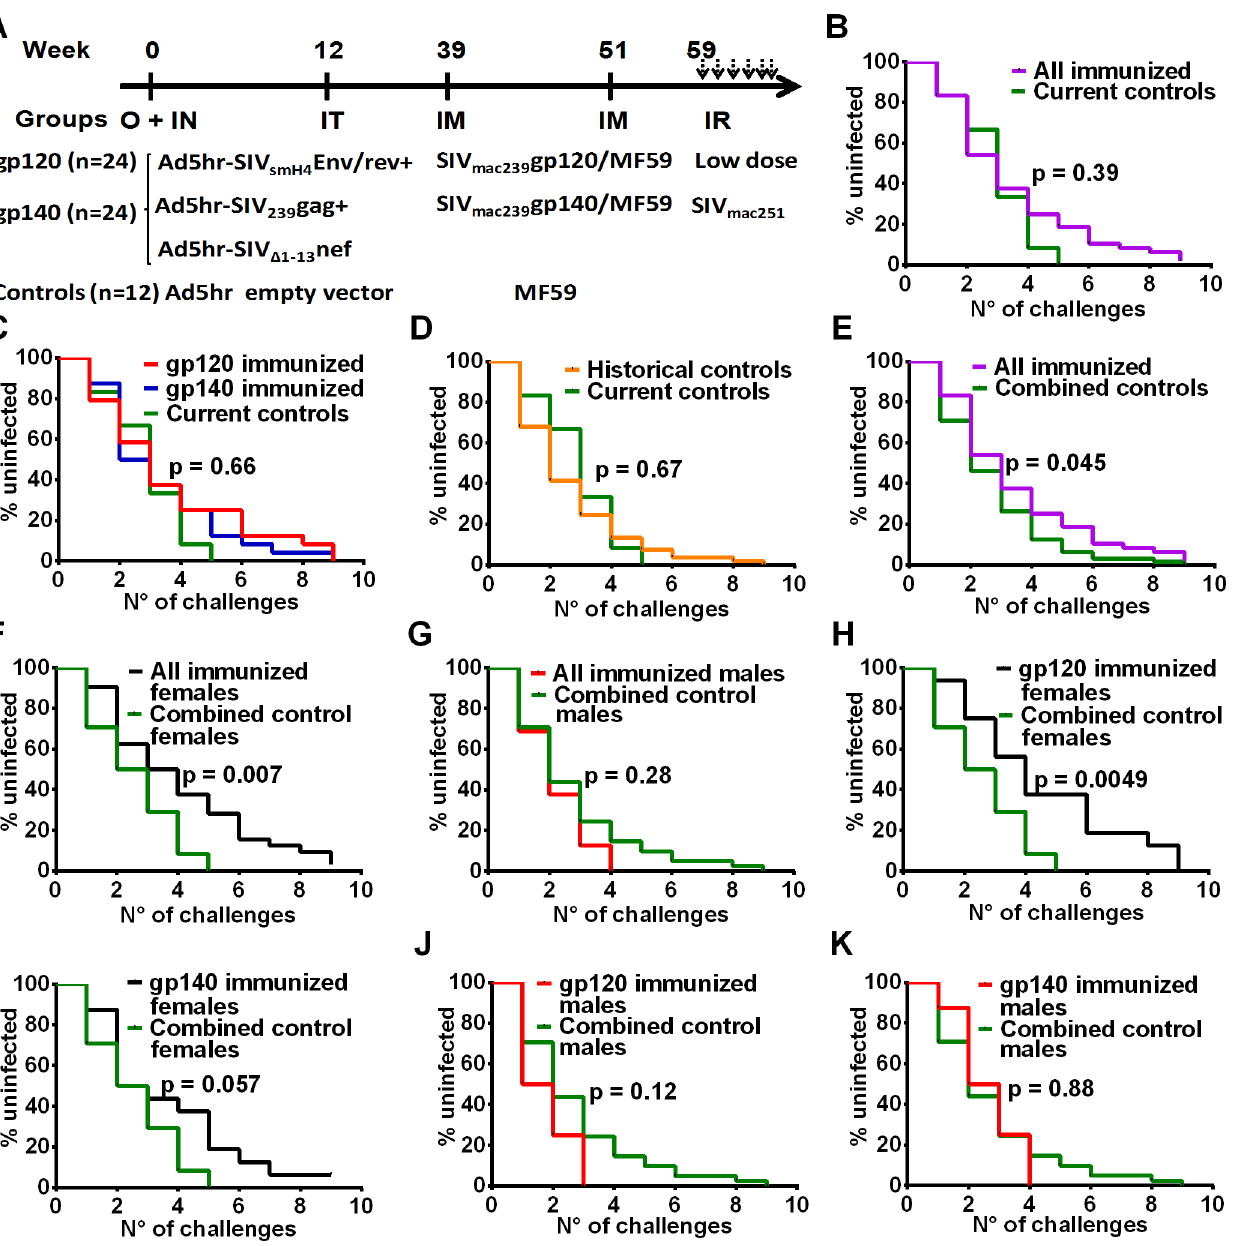
Fig 1. Immunization scheme and delayed acquisition after intrarectal repetitive SIV mac251 low dose challenges. (A) Immunization and challenge schedule. O = oral; IN = intranasal; IT = intratracheal; IM = intramuscular; IR = intrarectal. Dosages and further details are provided in on-line Methods. (B) No difference in SIV acquisition between all immunized macaques and current controls (n = 12). (C) No difference in SIV acquisition rate in gp120- and gp140-immunized macaques and current controls. (D) Similar acquisition rate in historical (n = 53) and current controls. (E) Delayed SIV acquisition in all immunized macaques compared to combined controls (n = 65). (F) Delayed SIV acquisition in all immunized females (n = 32) compared to combined control females (n = 24) but not (G) in all immunized males (n = 16) compared to combined control males (n = 41). (H) Delayed SIV acquisition in gp120-immunized females compared to combined control females. (I) Trend for delayed SIV acquisition in gp140-immunized females compared to combined control females. No difference in SIV acquisition rate in gp120-immunized males (J) and gp140-immunized males (K) compared to combined control males.